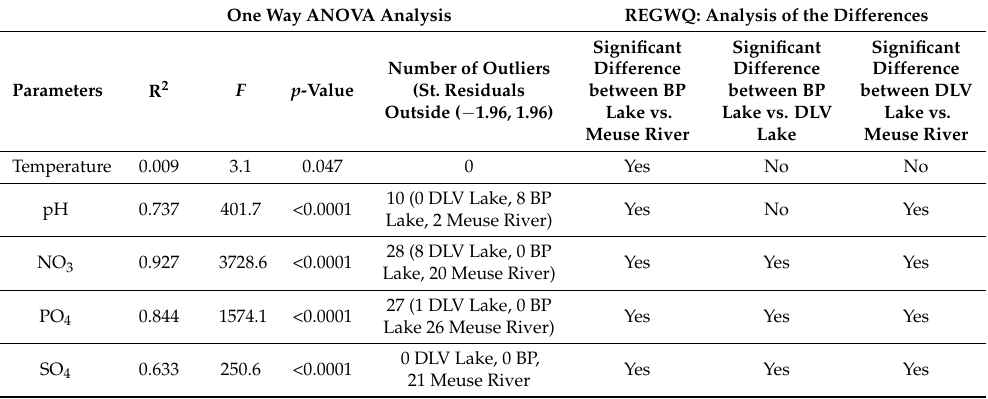
Table 3. Results of the one-way ANOVA, testing whether the mean value of time series of temperature, pH, NO 3 , PO 4 and SO 4 for each type of surface water (DLV Lake, BP Lake or Meuse River) is significantly different from an overall mean value. R 2 are the standard residuals, F is the Fisher F -value, p is the significance. Tests of difference for the time series for all three types of surface